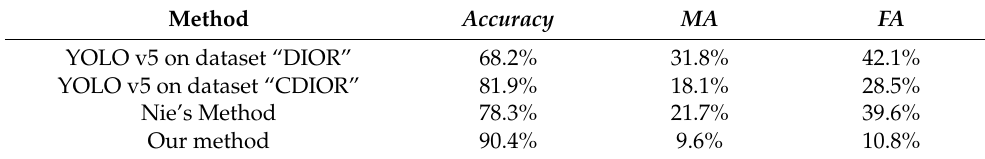
Table 3. Comparison of experimental results of different methods. The comparison parameters used are accuracy, MA and FA. The comparison methods are YOLO v5 on dataset “DIOR”, YOLO v5 on dataset “CDIOR”, and Nie’s